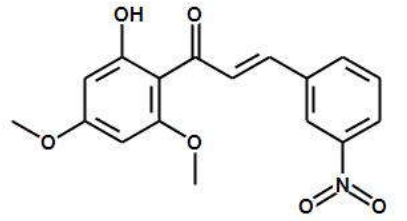
Figure 1. Chalcone CH8 (3-nitro-2-hydroxy-4,6-dimetoxychalcone).